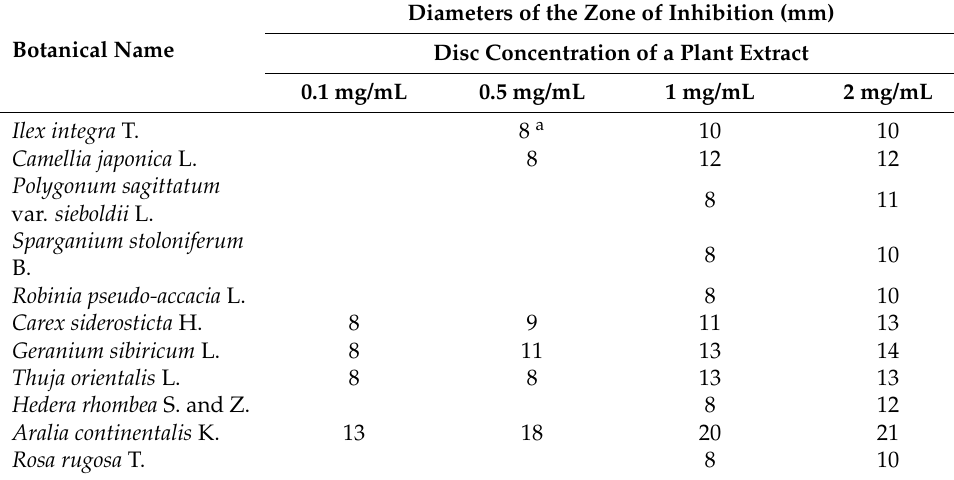
Table 4. Antimicrobial activities of plant extracts against P. acnes in disc diffusion